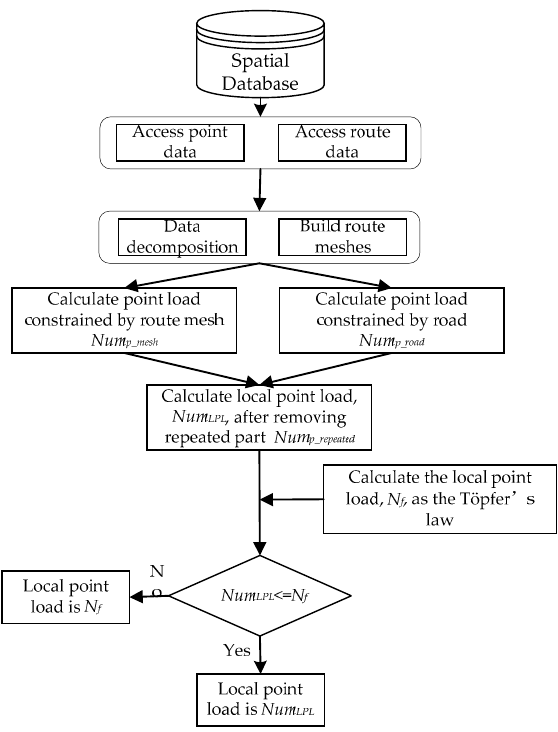
Figure 2. The flowchart of calculating the local point load.